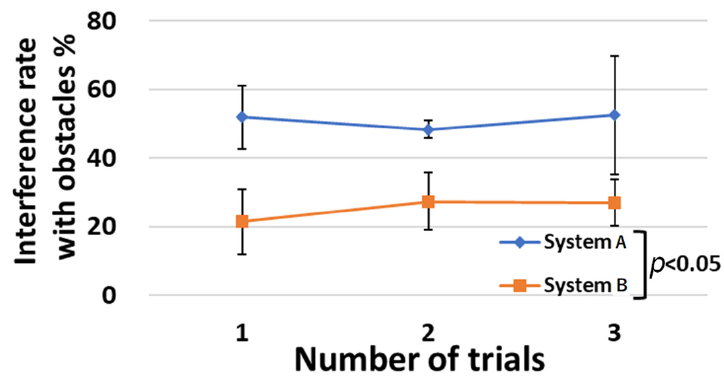
Figure 22. Interference rate with obstacles for each trial of three tasks.